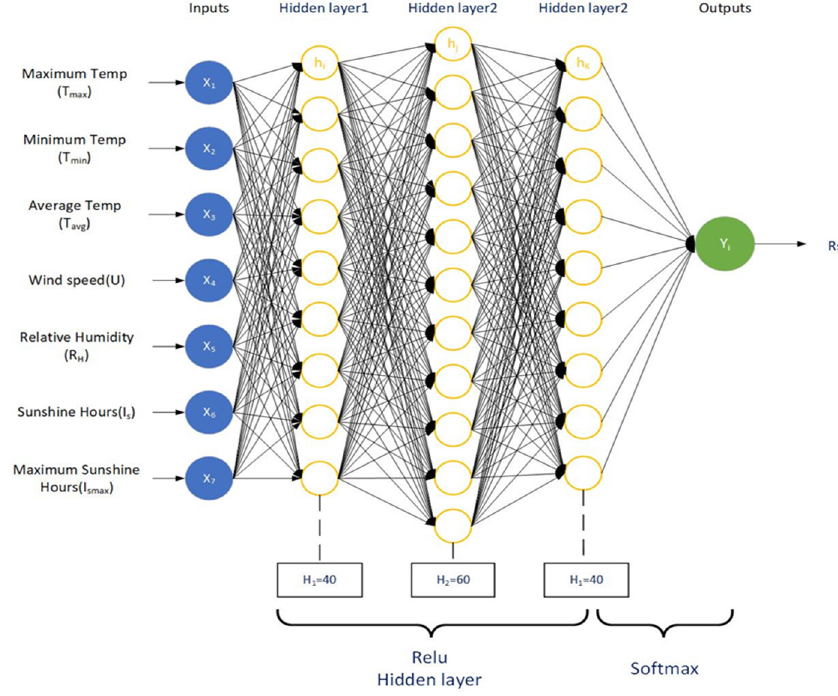
Figure 1. Framework diagram of deep learning model.